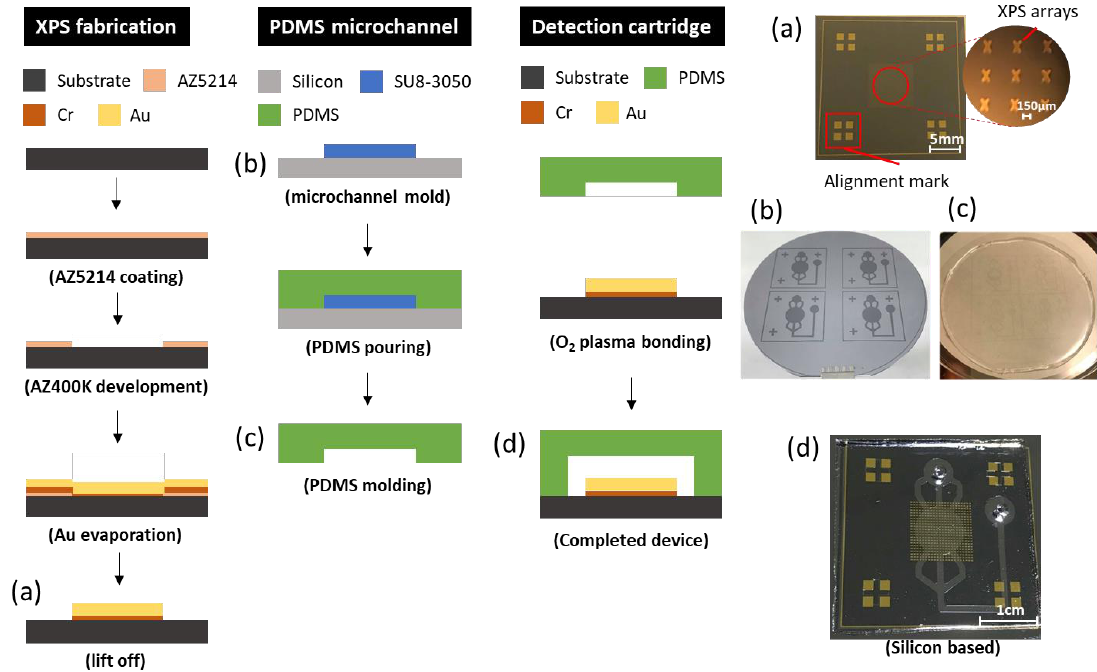
Figure 2. Fabrication: ( a ) XPS metamaterial; ( b ) SU8 mold; ( c ) PDMS microfluidic layer; ( d ) finished product (detection cartridge).